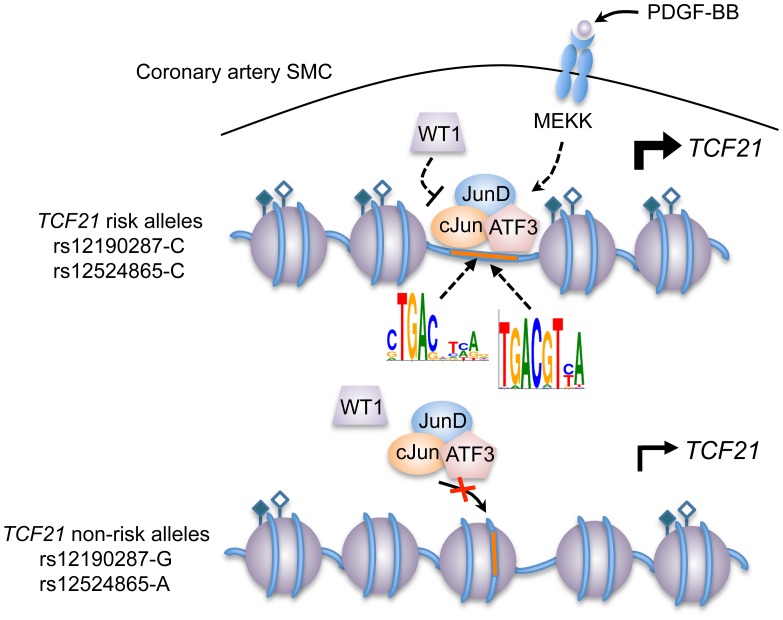
Predicted model of AP-1 dependent regulation of TCF21 at rs12190287 and rs12524865.Individuals carrying risk alleles for rs12190287 or rs12524865 at 6q23.2 are expected to have increased TCF21 expression upon stimulation of PDGFR-β by PDGF-BB in coronary artery smooth muscle cells, due to increased enrichment of active histone modifications (represented by closed and open diamonds) leading to an open chromatin conformation, allowing binding of an active AP-1 TF complex containing various combinations of c-Jun, JunD, and ATF3. WT1 functions as a transrepressor of this active complex at rs12190287, whereby WT1 may fine-tune the spatial and temporal activation of TCF21 expression. Multiple kinases other than mitogen-activated kinase (MEKK) may be involved in the activation and recruitment of AP-1 complexes to these binding sites.